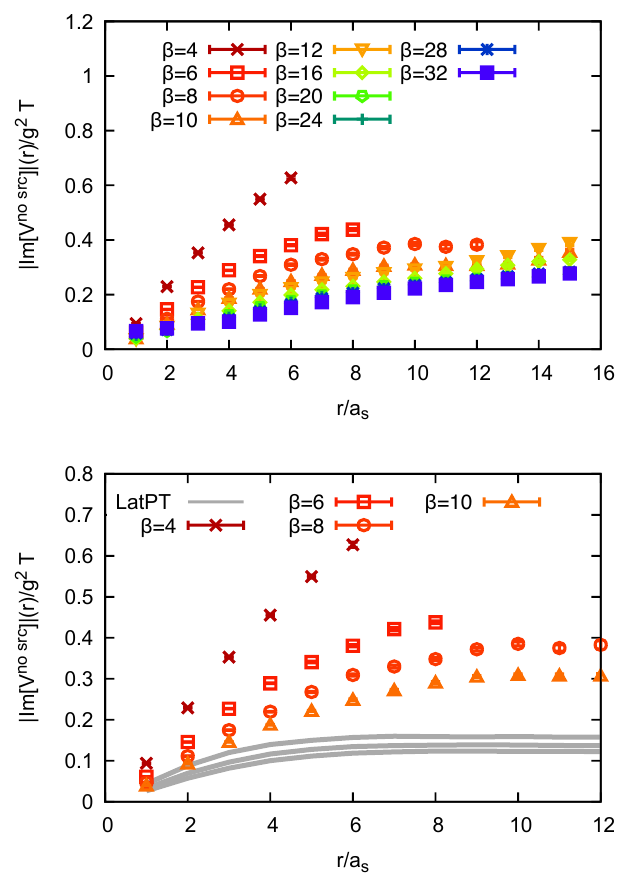
Figure 3 . (top) Imaginary part of the static quark potential evaluated at different temperatures β = 4 . . . 32 on N x = 32 lattices in the absence of a back-reaction between static sources and the surrounding medium. (bottom) Comparison of the results at the four highest temperatures to the corresponding values from lattice perturbation